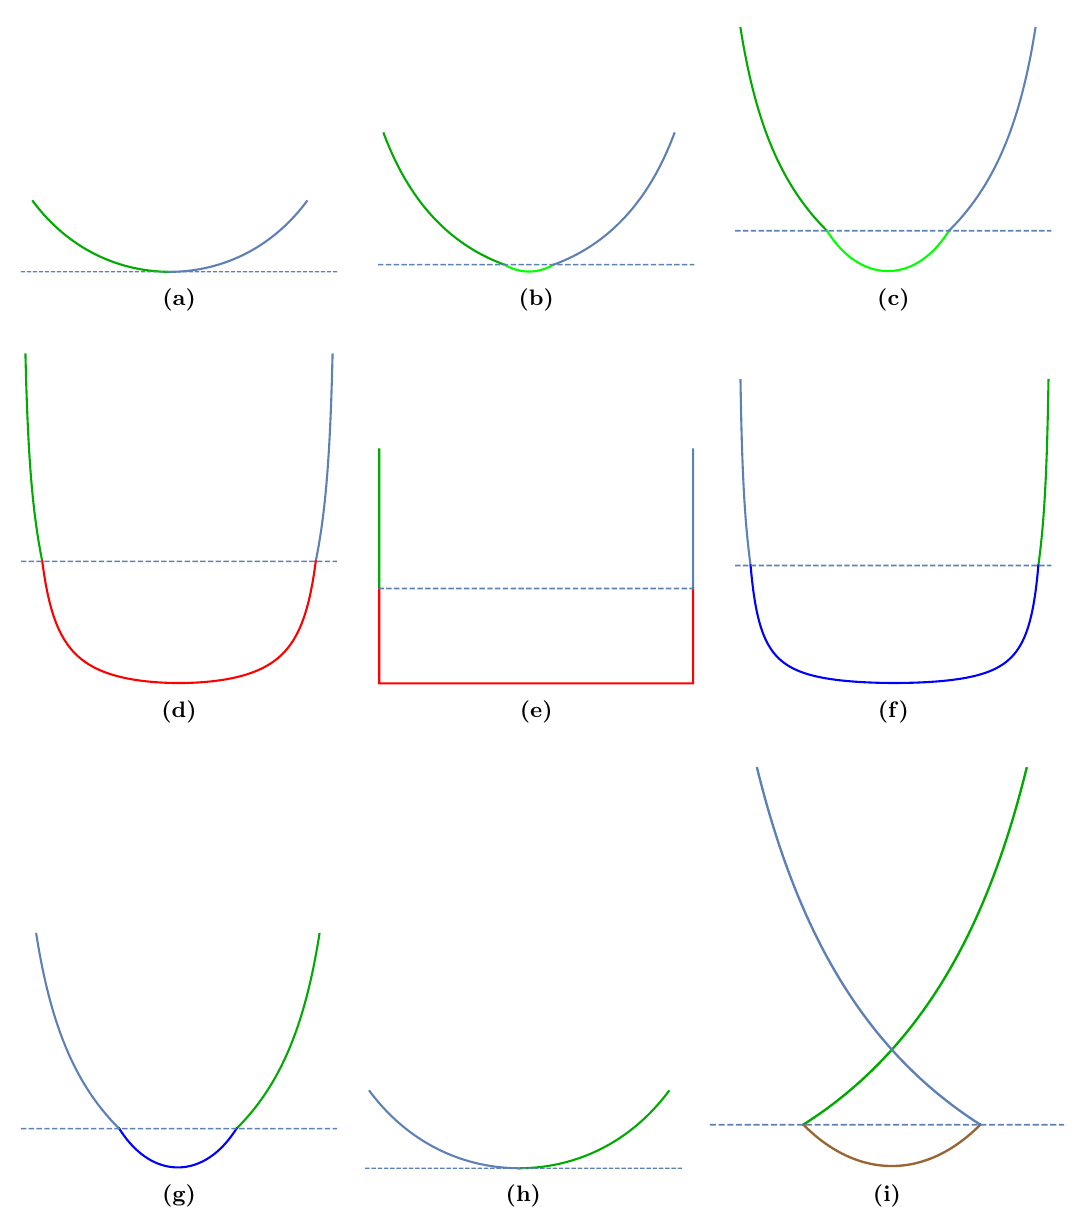
Figure 12 . First part of geodesic plots. The plots depict the behaviour of the dominant geodesic as we vary (cid:1) X + . The horizontal axis is X + and the vertical axis is U . The dashed line is the position of the shell at u (cid:3) . We have set u (cid:3) = 0 : 95, M = 1. The external segment of the geodesic that comes from s < 0 is with dark green colour (segment I in (cid:12)gure 5). The segment II of the geodesic inside the shell has colour that corresponds to the colour of the branches in (cid:12)gure 6.